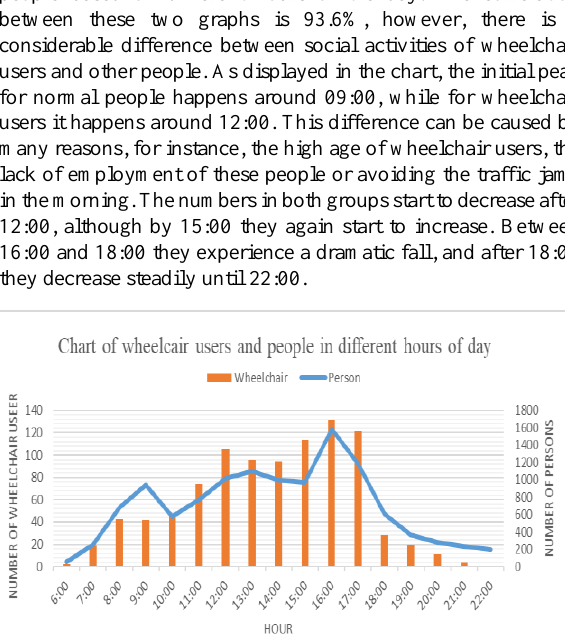
Figure 1. YOLOv3 network Architecture